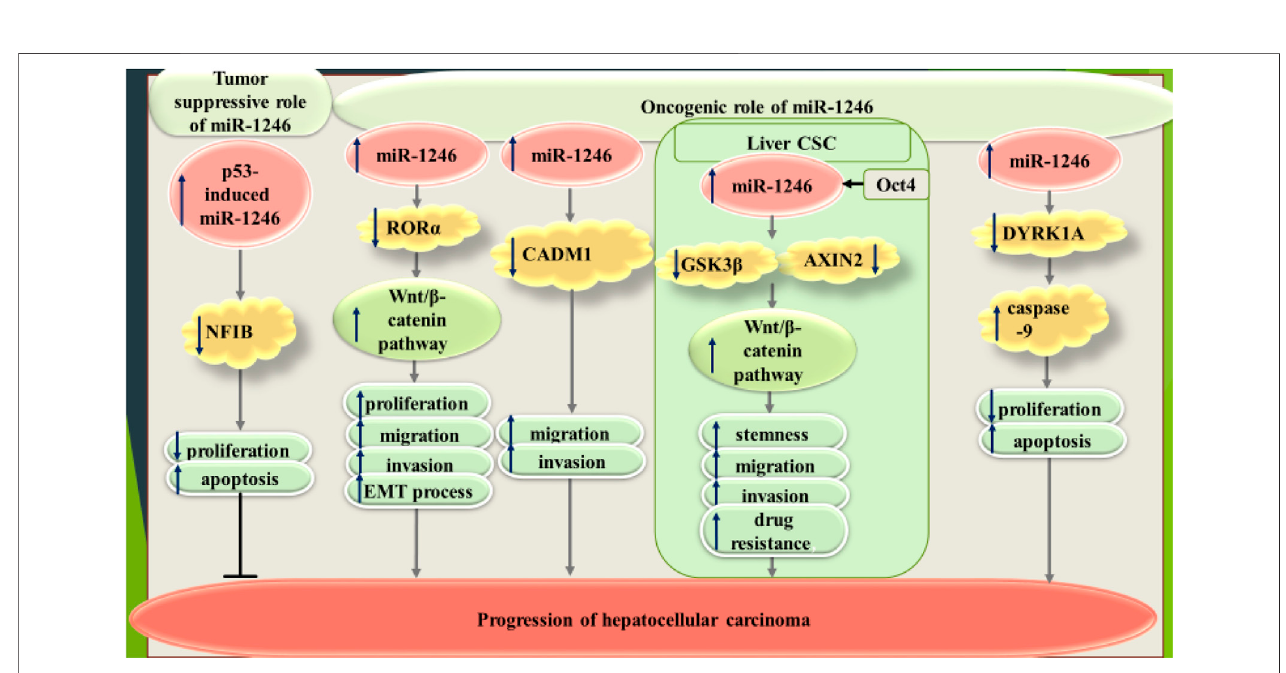
FIGURE 4 | Dual roles of miR-1246 in hepatocellular